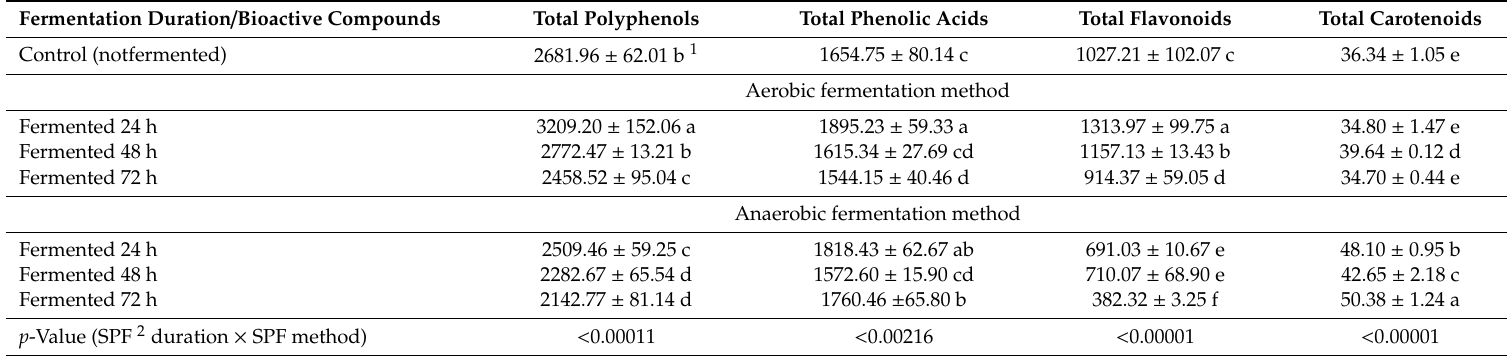
Table 2. The influence of solid-phase fermentation (SPF) on the matter of bioactive compounds (mg 100 g − 1 dry weight (DW)) in organic willowherb leaves. Mean value ± standard error, n = 3.